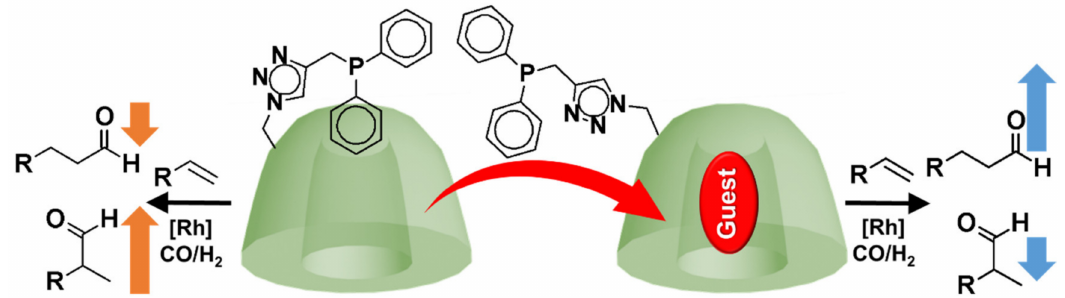
Figure 17. Cyclodextrin–phosphine with a guest-tunable conformation for biphasic, aqueous, and rhodium-catalyzed hydroformylation.